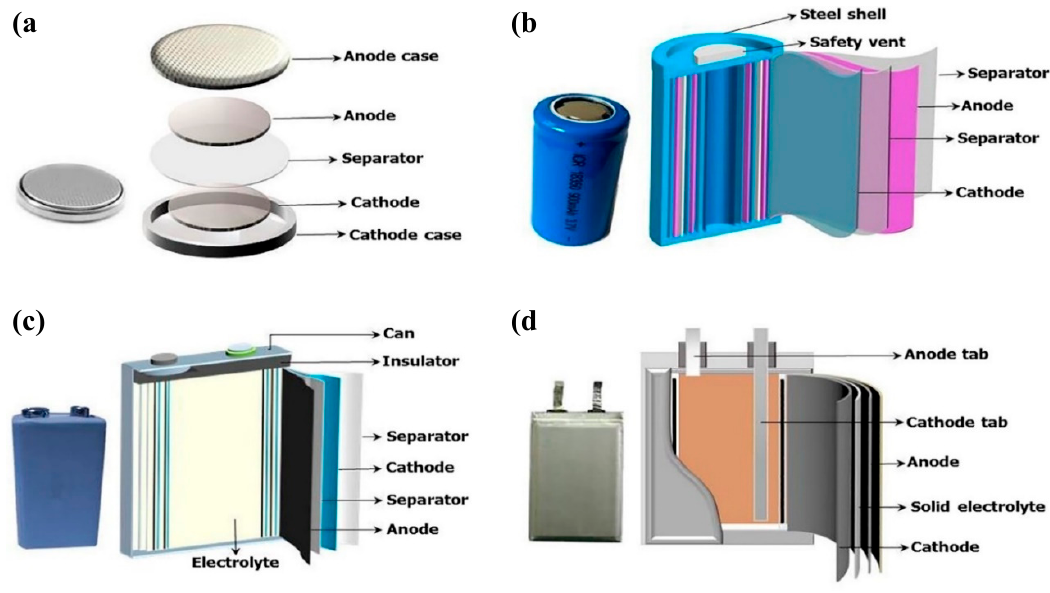
Figure 8. Schematic illustration of a typical rechargeable battery cell in different configurations: ( a ) coin, ( b ) cylindrical, ( c ) prismatic, and ( d ) pouch shaped [57].